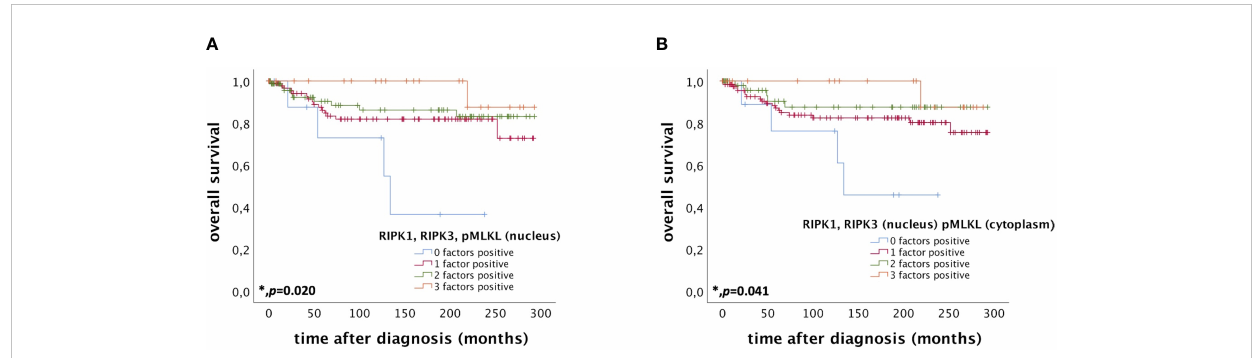
FIGURE 4 OS of patients diagnosed with cervical cancer correlated with co-expression of RIPK1, RIPK3, and pMLKL. (A) OS of patients diagnosed with cervical cancer correlated with co-expression of RIPK1, RIPK3, and pMLKL in the nucleus. Expression of all three factors (RIPK1, RIPK3, and pMLKL) (n = 22) in the nucleus was associated with longer OS in cervical cancer patients (p = 0.020) compared to patients expressing only two (n = 75), one (n = 97) or no factor (n = 9). (B) OS of patients diagnosed with cervical cancer correlated with co-expression of nuclear RIPK1 and RIPK3 and cytoplasmic pMLKL. Expression of all three factors (nuclear RIPK1, nuclear RIPK3 and cytoplasmic pMLKL) (n = 20) was associated with longer OS in cervical cancer patients (p = 0.041) compared to patients expressing only two (n = 51), one (n = 122) or no factor (n =